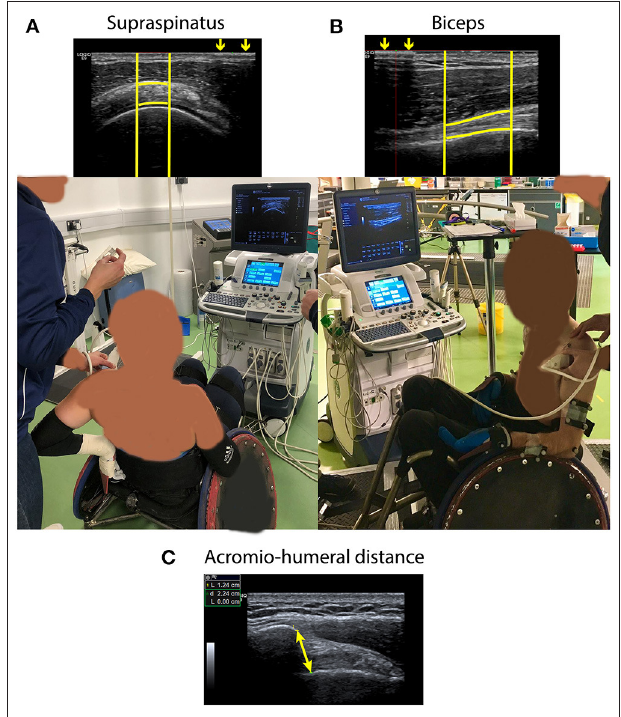
FIGURE 1 | (A) Ultrasound image of supraspinatus tendon taken following Quantitative Ultrasound Protocols (QUS) and position in which the image was taken. (B) Ultrasound image of biceps tendon taken following QUS and position in which the image was taken. For both (A) and (B) , arrows demonstrate the interference pattern that resulted from a metal marker taped to the skin from which the bright vertical lines were defined. Bright horizontal lines following the tendon borders are manually defined. (C) Ultrasound image of the acromio-humeral distance (i.e., the shortest distance between the anterior inferior edge of the acromion and the humeral head). The image was taken in the same position as the image of the biceps tendon, but with the thumbs facing